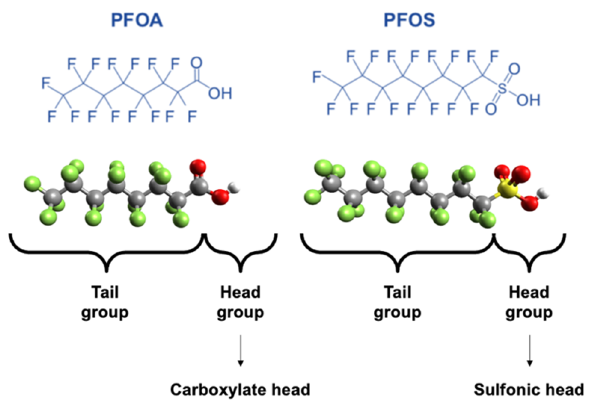
Figure 1. PFOA and PFOS chemical structures.